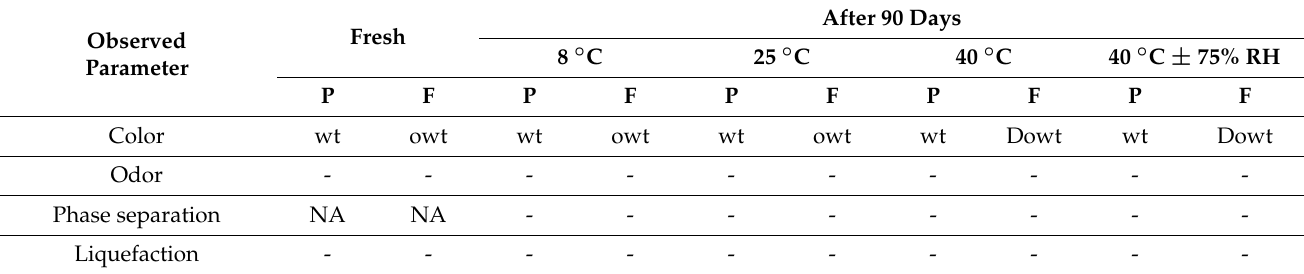
Table 6. Organoleptic evaluation of fresh formulations and after 90 days at different